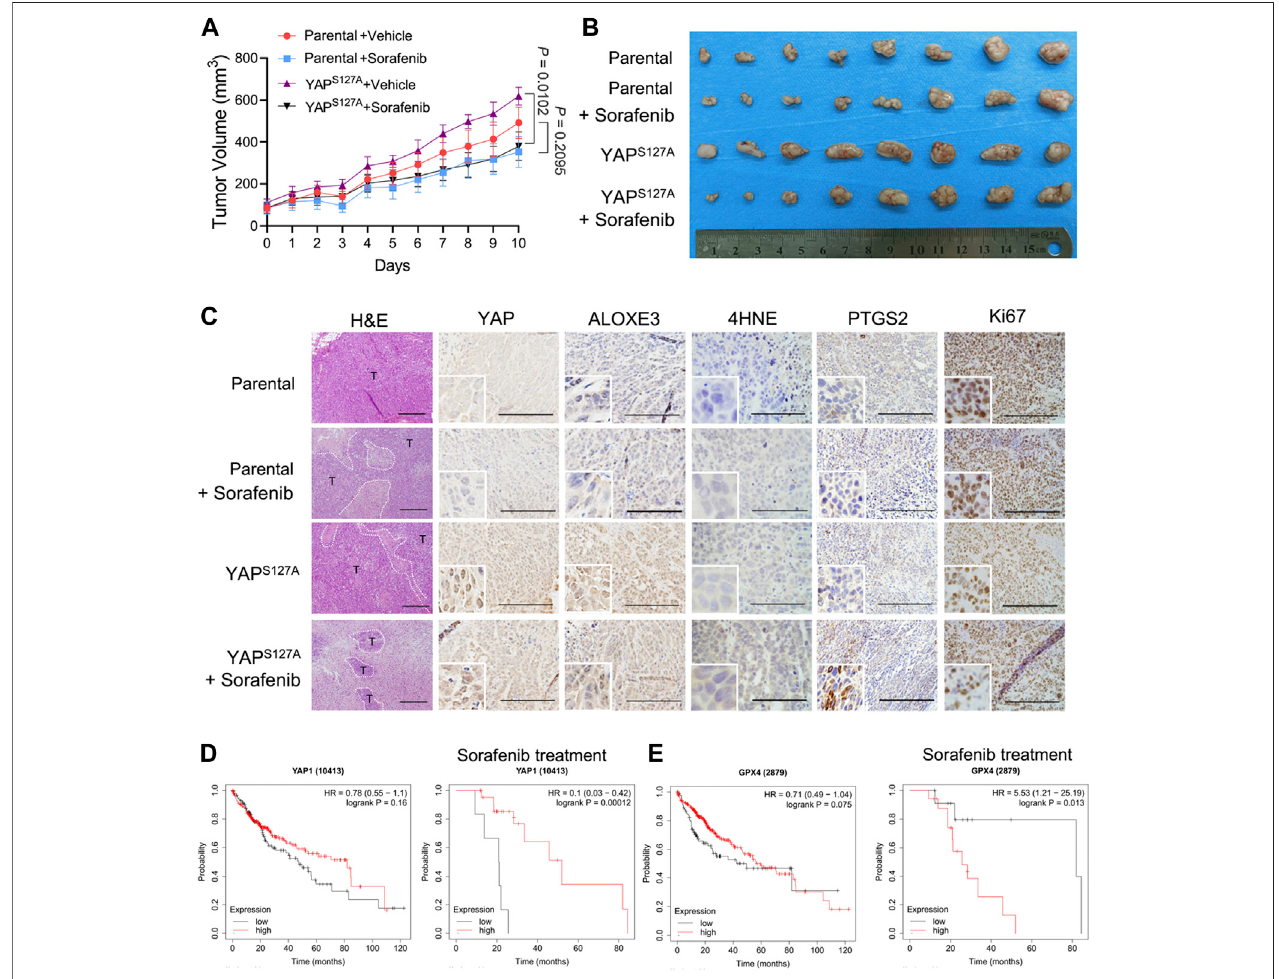
FIGURE8| Thecancertherapeutic potential offerroptosisinduction withsorafenibinHCC withenhanced activationofYAP.Parentalor YAP S127A -overexpressing LM3 cells (2 × 10 6 ) were injected subcutaneously into nude mice. The average volume of tumors was allowed to reach ∼ 100 mm 3 , mice bearing tumors were orally administeredwith50 mg/kgsorafenibdailyfor10 days. (A) Growthcurvesoftumorsofeachgroup. n (cid:2) 8,onthelinearscaleforactualtumorsize. (B) Imagesofresected tumorsfrommice xenograftedwithparental orYAP S127A -overexpressing LM3 cells. (C) Representative H&Eand immunostaining images ofYAP, ALOXE3, 4HNE, PTGS2andKi67.Scalebarsfor4HNE,100 μ m.Scalebarsforothers,200 μ m. (D) ComparisonofthesurvivalcurvesofYAPwithhighandlowexpressioninHCCwithor without sorafenib treatment in the GEPIA database. (E) Comparison of the survival curves of GPX4 with high and low expression in HCC with or without sorafenib treatment in the GEPIA